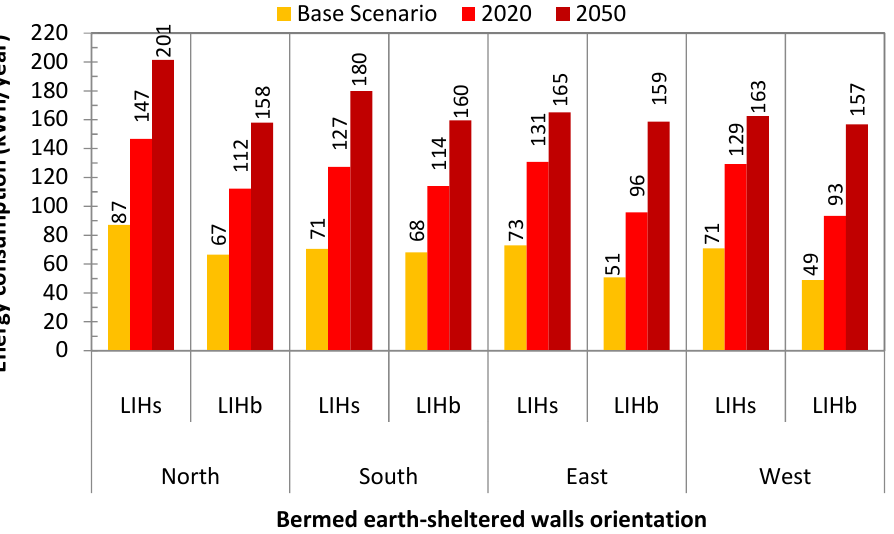
Figure 5. Weighted monthly average annual thermal load of the bedrooms’